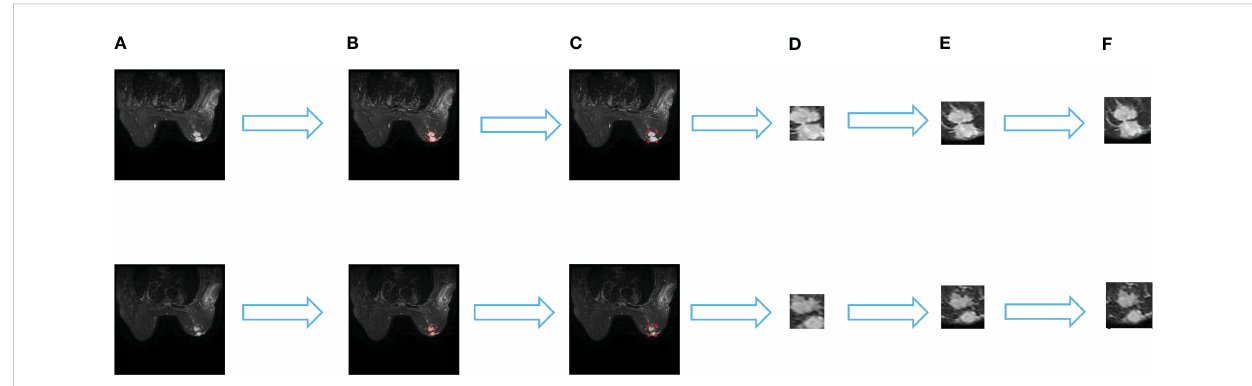
FIGURE 1 Data set processing process. (A) is the original image, (B) is the speci fi c outline of the tumor sketched by the physician, (C) is the four edge points in the speci fi c outline, (D) is the minimum matrix covering the tumor, (E) shows that 10 pixels are added to each direction of the four points to crop the outline area. and (F) is the cropped image uniformly resized to 64×64 pixels by a bilinear interpolation